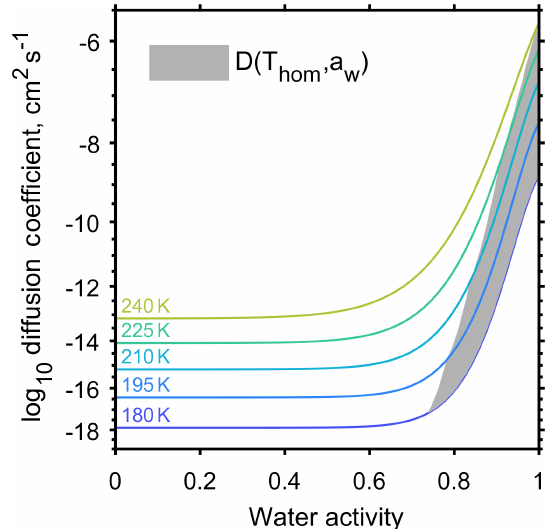
Figure 3. Water diffusion coefficient through α -pinene secondary organic aerosol as a function of temperature and water activity adapted from Viscous organic aerosol particles in the upper tropo- sphere: diffusivity-controlled water uptake and ice nucleation? by Lienhard et al. (2015). The grey region shows where the conditions of homogeneous freezing and diffusion coefficient